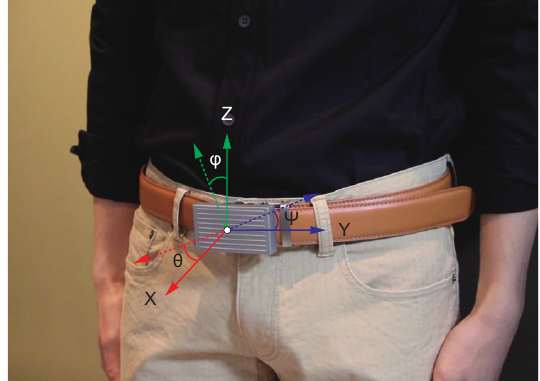
Figure 6. Attitude angle of WaistonBelt